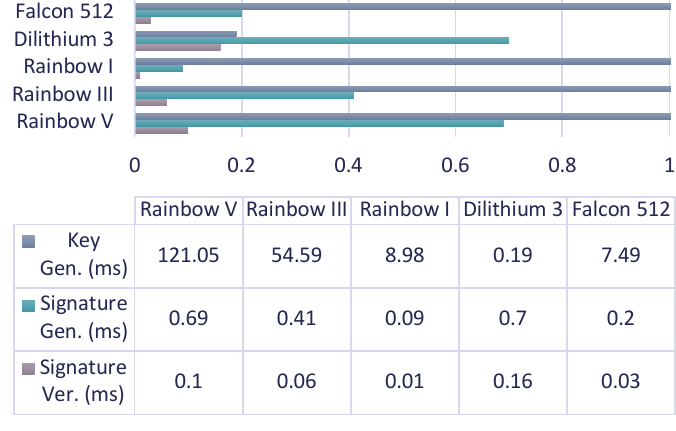
Figure 3. Execution time of post-quantum signature cryptosystems